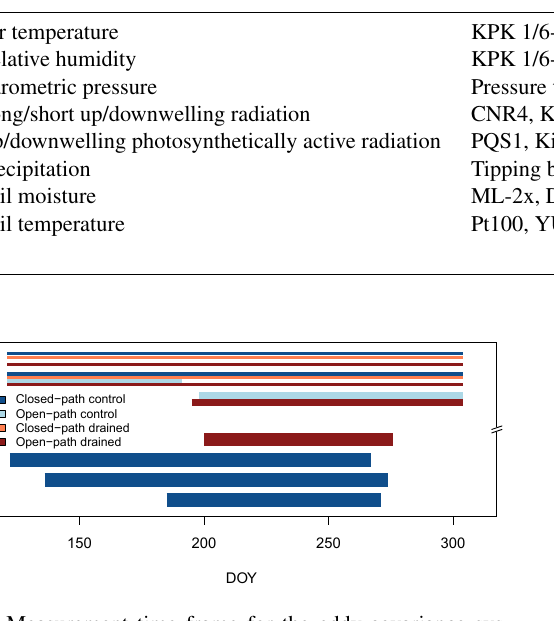
Figure 2. Measurement time frame for the eddy-covariance sys- tems (open-path: LI7500; closed-path: LI6262 and FGGA) of both towers, for both the recent (2013–2015) and historic (2002–2005) observation